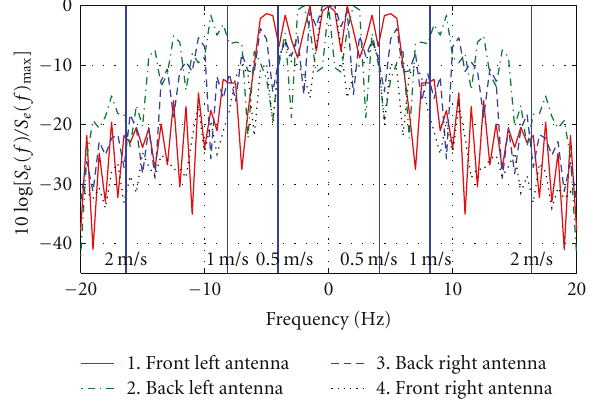
1. Front left antenna 3. Back right antenna 2. Back left antenna 4. Front right Figure 9: Power spectral density for the firefighter with four antennas in a LoS situation (path 1, LoS, 1m/s; TX in B, RX in A).